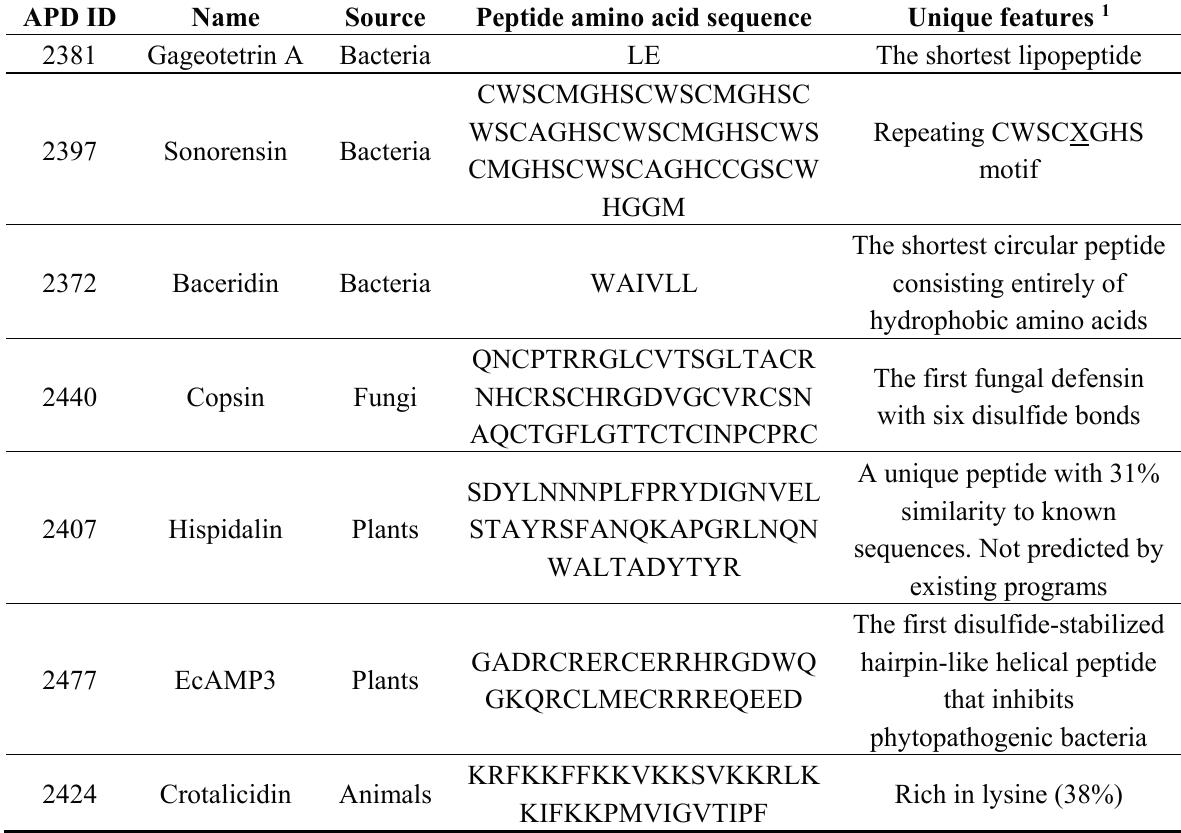
Table 1. Select antimicrobial peptides discovered in